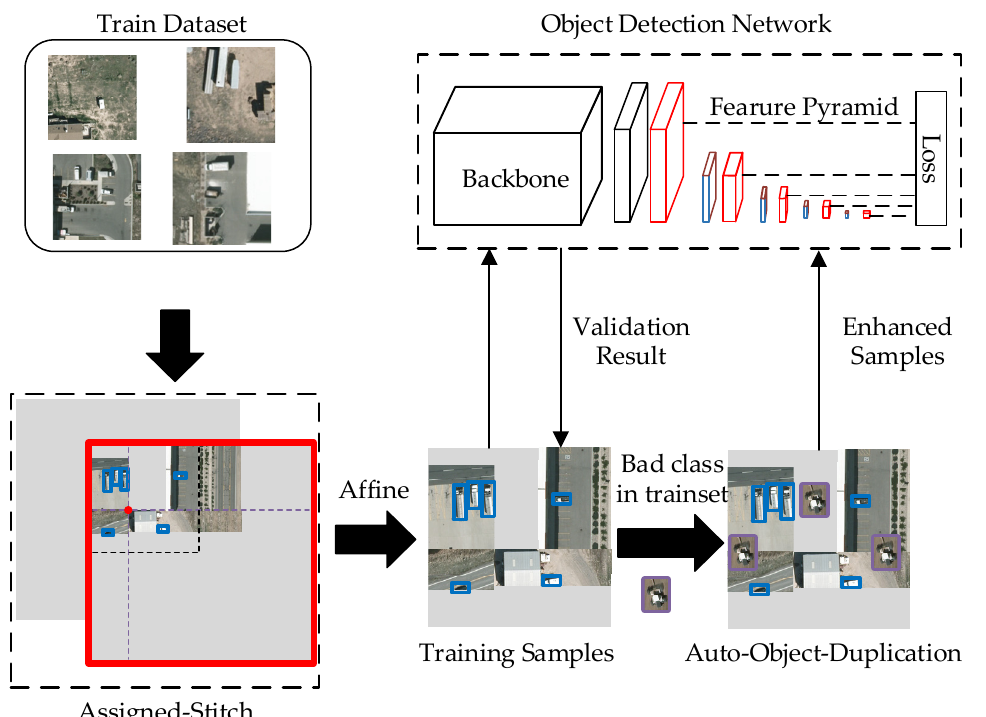
Figure 6. Aggregated-Mosaic architecture.